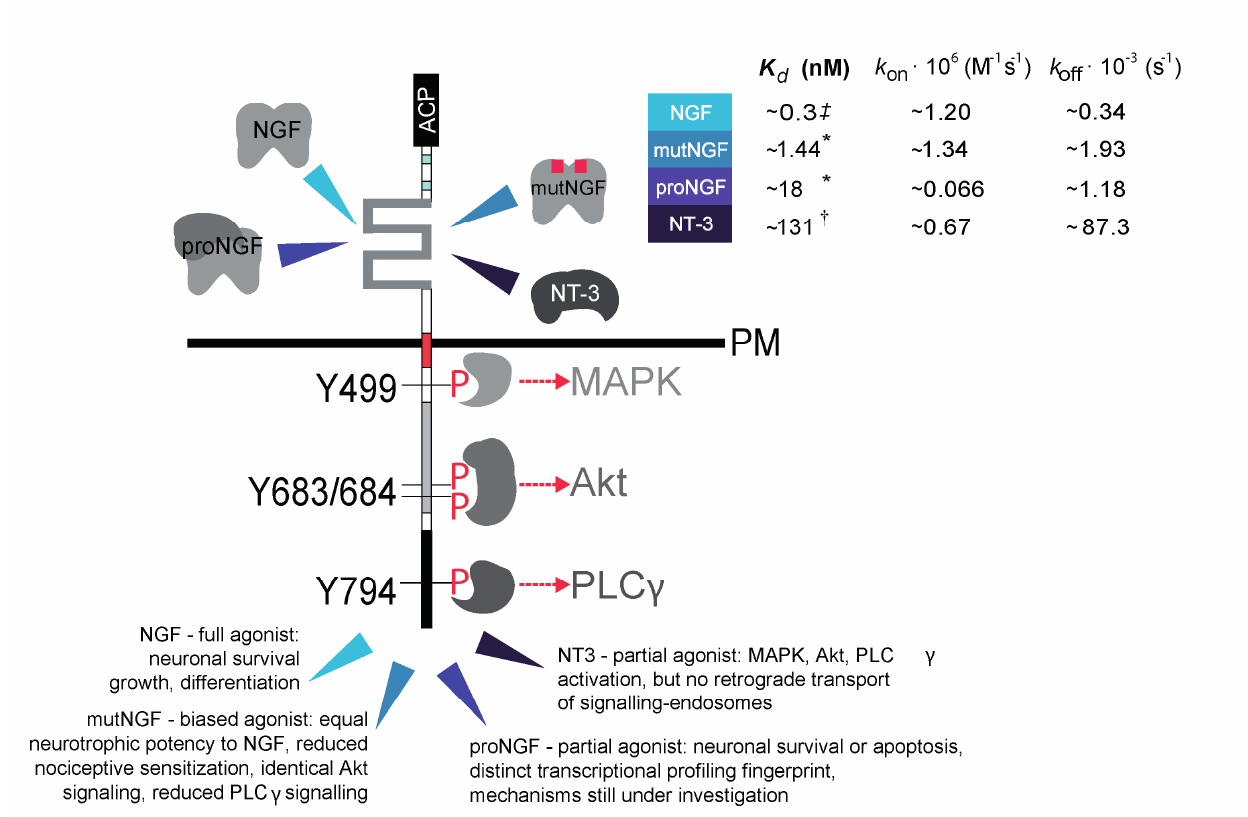
Figure 2. Schematic picture of four different NTs binding to ACP-TrkA. The ACP-TrkA construct and the four ligands investigated for receptor binding [104] are schematically depicted. NGF, NGF R100E mutant (mutNGF, related to HSANV disease [132]), proNGF and NT-3 all bind to the extracellular domain of TrkA receptor but with different affinity, as quantified by the K d (dissociation constant) values (see the color-coded arrowheads referring to the corresponding K d values, which are taken from: ≠ [133]; * [134]; † [135]). The evoked physiological responses are also different among the four ligands and are summarized at the C -terminus of the receptor, highlighted by arrowheads with the same color-code. Intracellular effectors recruited at phosphorylated tyrosine residues and leading to the activation of the MAP kinase, the Akt and PLC γ signaling pathways, upon TrkA-NT binding are also schematically depicted. The numbering of tyrosine residues refers to the rat TrkA cDNA sequence. Note that while Y499 and 794 only have recruitment function, Y683/4 constitute with Y679 (not depicted) the activation loop of tyrosine kinase activity. The figure has been adapted from